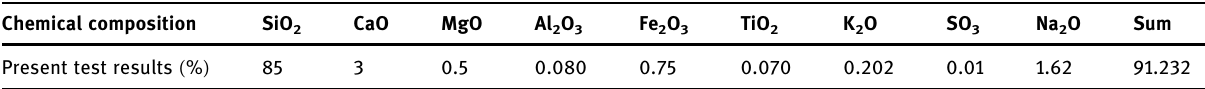
Table 1: XRF of porcelanite compound Chemical composition